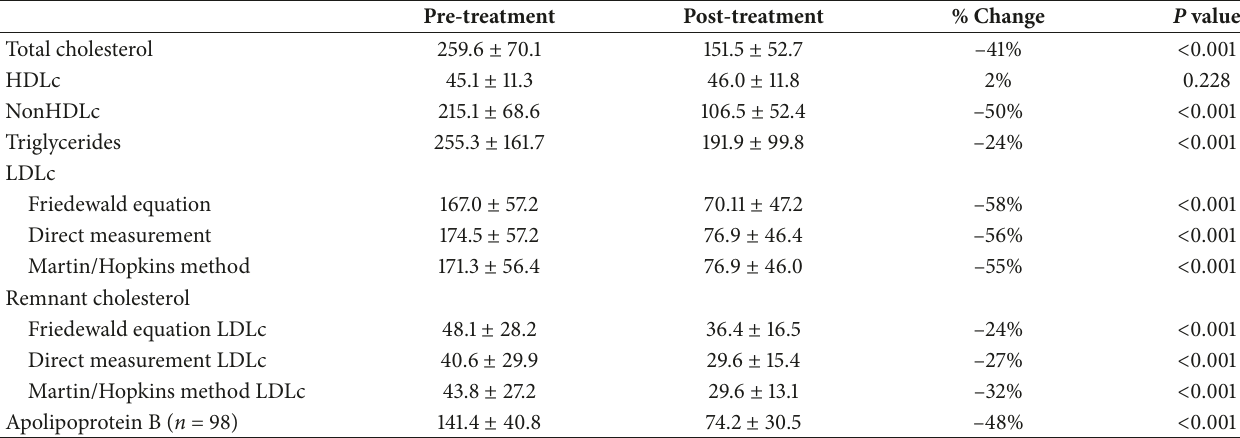
Table 2: Lipid levels before and after